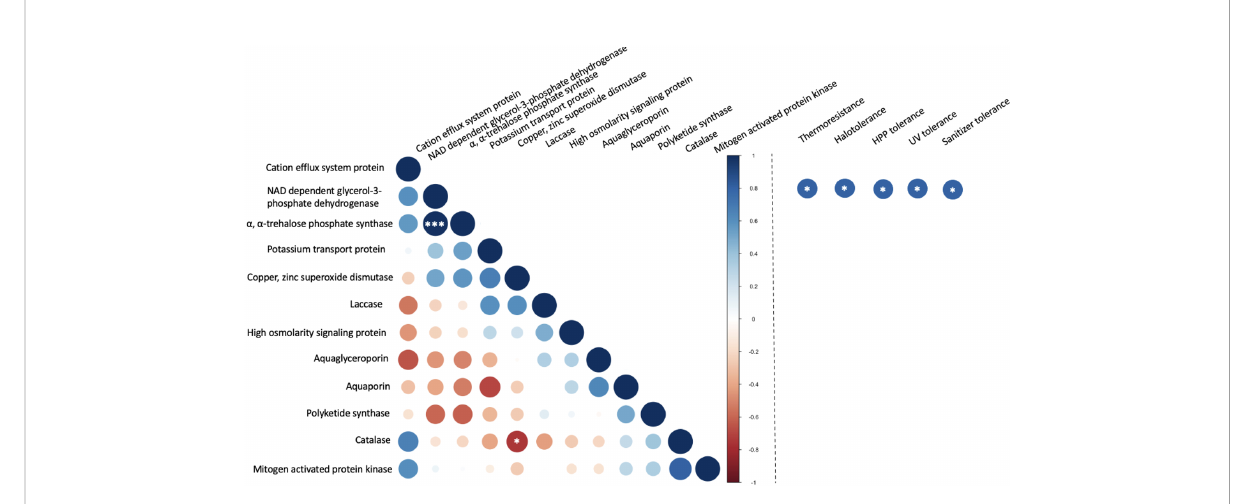
FIGURE 7 Correlation between the number of stress-related genes in food-relevant black yeast (left) and between gene number and stress tolerance phenotype (right). *p < 0.05 ; **p < 0.01 ; ***p <